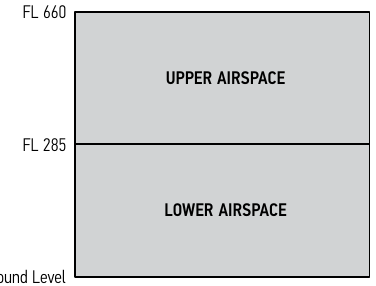
Fig. 5. The proposed division of the analysed airspace at FL 285